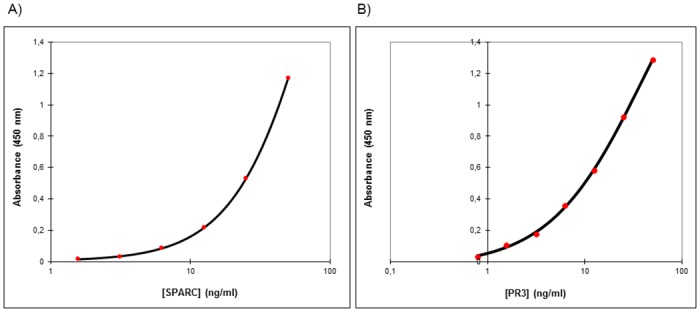
Standard curve validation of A) SPARC (R2 = 0.999) and B) PR3 (R2 = 0.996).